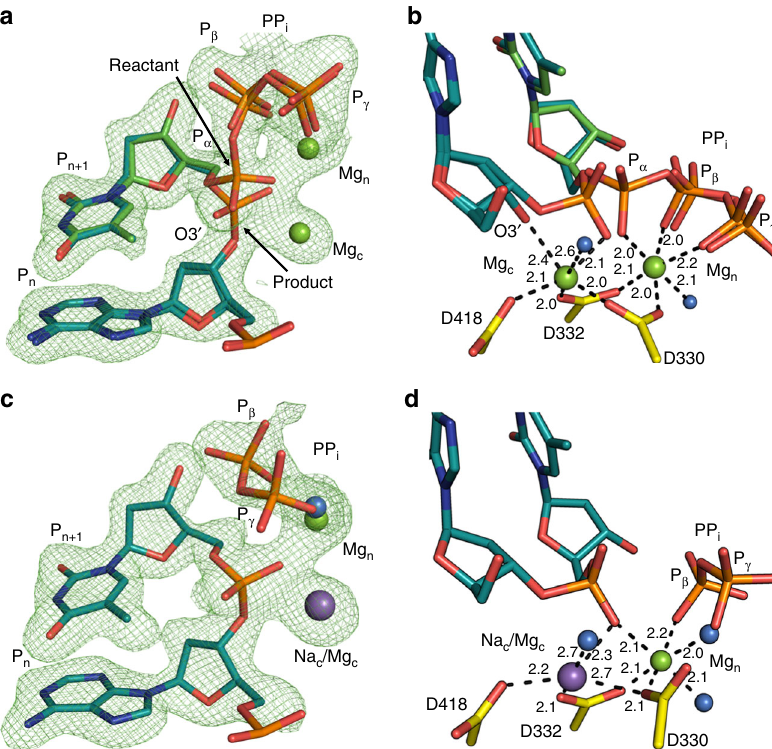
Fig. 3 Magnesium-mediated insertion. Soaking of the Ca 2+ -bound pre-catalytic GS ternary complex in a cryo-solution containing 10 mM MgCl 2 initiates the reaction in the crystal. Crystals were frozen after incubation for the indicated times in the cryo-solution. a , b Reaction state (RS) at 15 min, c , d product state (PS) at 60 min. The panels on the left ( a , c ) display density for the incoming and incorporated nucleotides. The panels on the right ( b , d ) are close-up views of a 90° rotation of the active site with coordinating ligands indicated by dashes and labeled distances (Å). The incoming TTP and incorporated nucleotides (TMP) are in cyan and green stick representation, respectively, while the protein side chains are in yellow . Mg 2+ ions are displayed as green spheres and water molecules as blue spheres . Sodium is shown as a large purple sphere . The F o – F c simulated annealing omit map ( green mesh ) shown is contoured at 2.5